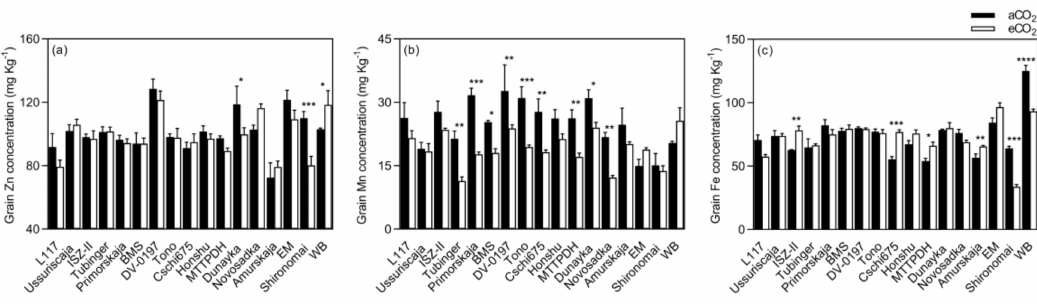
Figure 8. Grain micronutrient ( a – c ) concentrations of soybean grown under aCO 2 (400 ppm) and eCO 2 (800 ppm). Each bar represents the mean ± SE ( n = 10 plants). * p < 0.05; ** p < 0.01; *** p < 0.001; **** p < 0.0001 significance level.